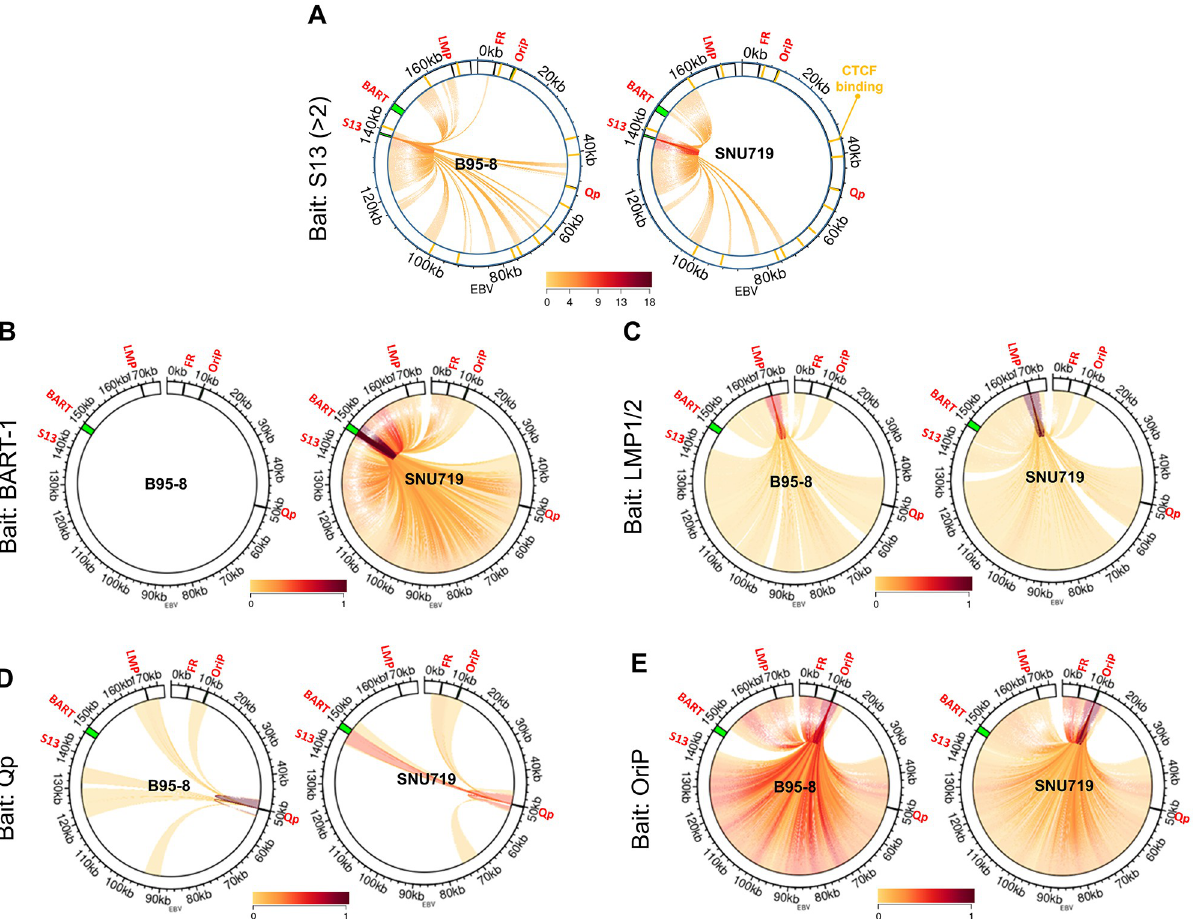
Fig 5. 4C-plots on EBV genome. Significant genomic associations of target viewpoint regions in B95-8 and SNU719 EBV genomes identified by 4C-Seq assays. A) To compare EBV genomic associations with the S13 locus, we adjusted the 4C-seq read numbers from S13 viewpoint primer set to 3,000 in the 4C-seq analysis of B95-8 and SNU719 cells (S5 Table). B-E) To compare EBV genomic associations with other loci such as BART-1, LMP1/ 2, Qp, and OriP, total read numbers from all target viewpoints were adjusted to 7,000,000 in each cell (S4 Table). 4C-seq assays revealed all interactions of BART-1 (B) , LMP1/2 (C) , Qp (D) , and OriP (E) regions in B95-8 and SNU719 EBV genomes. Locations of viewpoint primer sets were posted in S3 Table; S13 (EBV 138504 ~ 138987), BART-1 (EBV 147357 ~ 147490), LMP1/2 (EBV 166480 ~ 166661), Qp (EBV 50278 ~ 51579), OriP (EBV 9918 ~ 10302) and FR (EBV 4731 ~